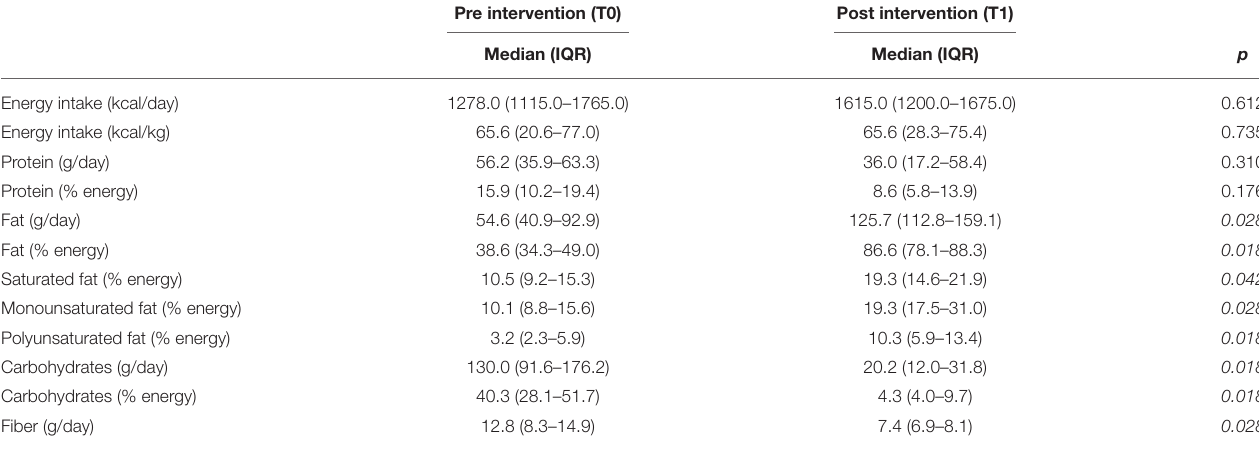
TABLE 1 | Daily dietary intake before and after the treatment with KD.